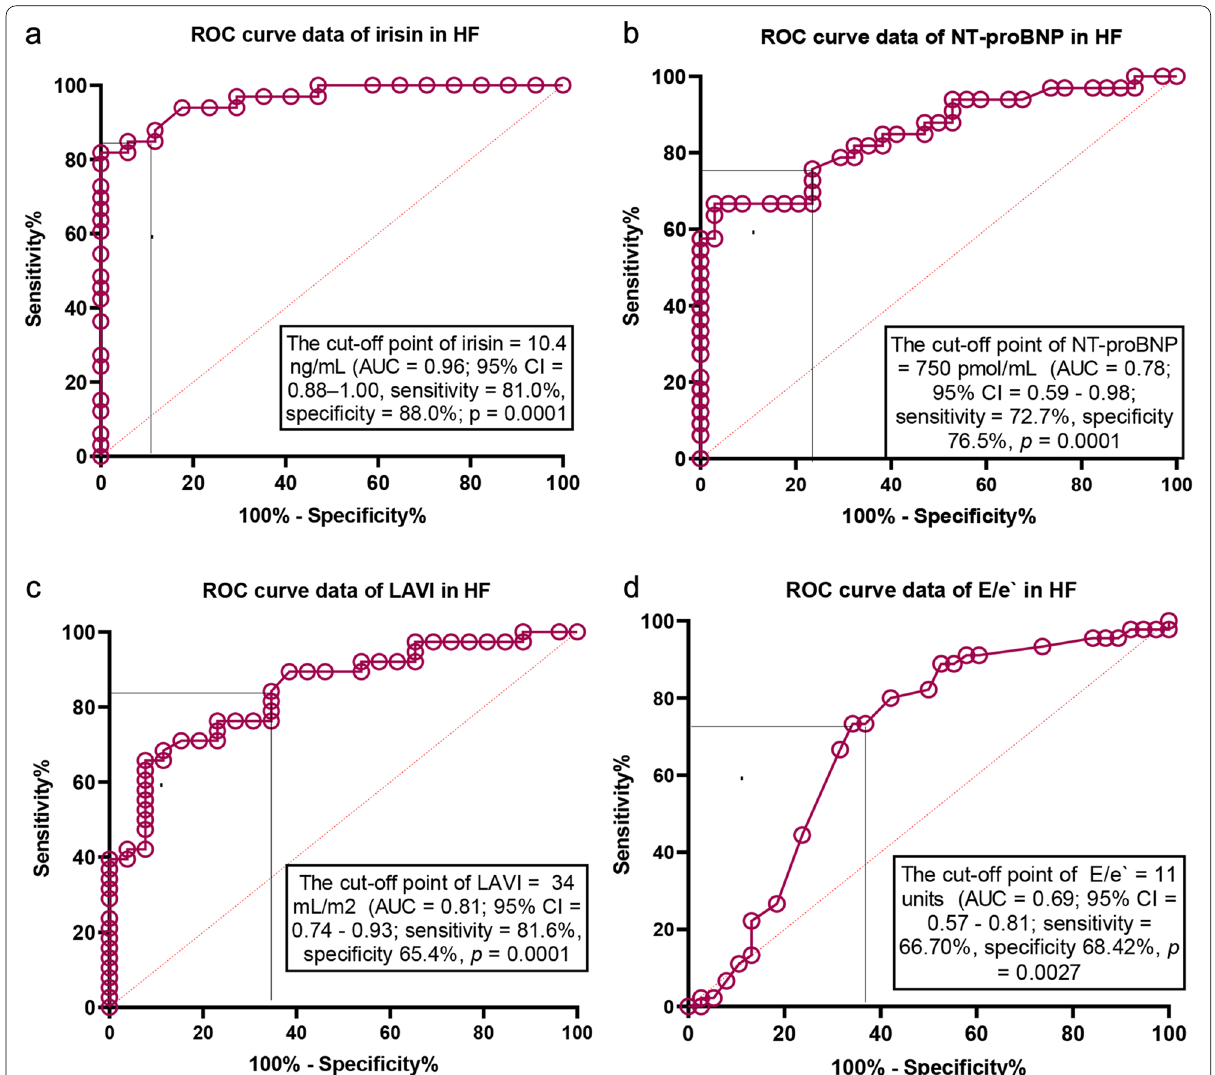
Fig. 1 Reliability of the predictive models for HF. The results of ROC curve analysis. a ROC curve data of irisin in HF. b ROC curve data of NT-proBNP in HF. c ROC curve data of LAVI in HF. d ROC curve data of E/e` in HF. Abbreviations: AUC, area under curve; CI, confidence interval; HF, heart failure; LAVI, left atrial volume index; E/e`, early diastolic blood filling to longitudinal strain ratio; NT- proBNP, N-terminal brain pro-natriuretic